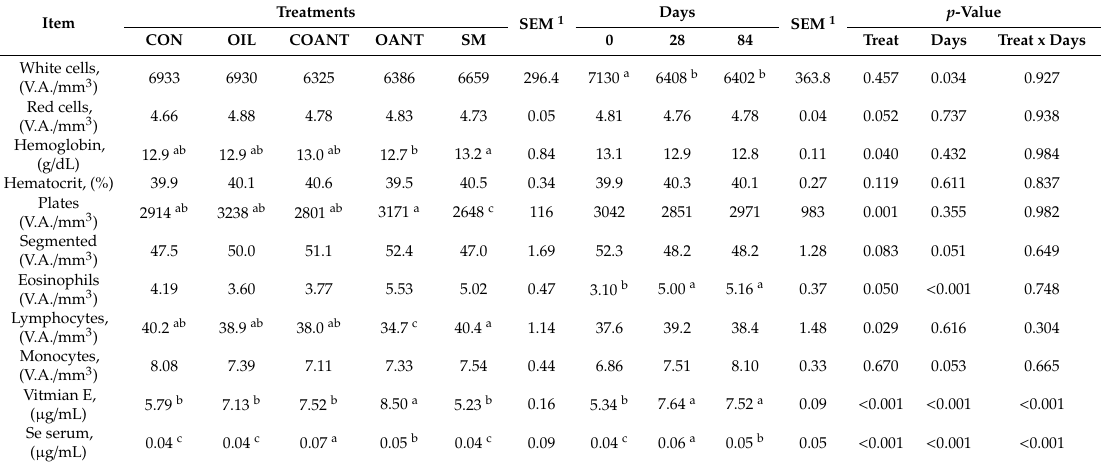
Table 3. Blood metabolites in children according to treatments and collection